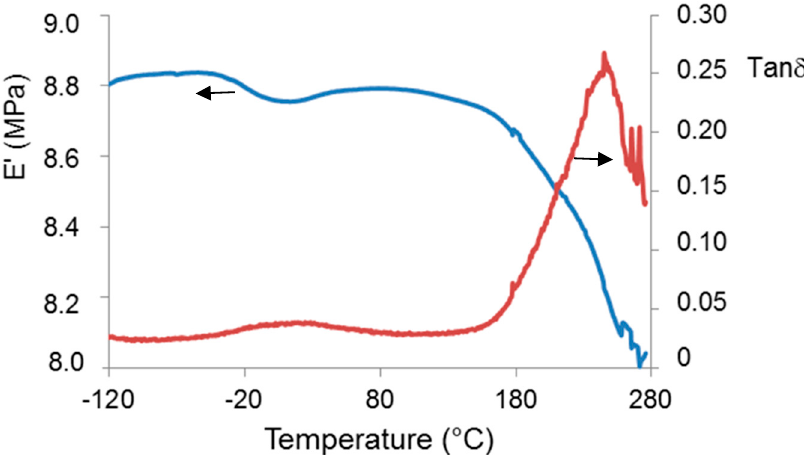
Figure 4. Dynamic–mechanical curves (red curve: loss tangent, tan δ ; blue curve: storage modulus, E’) of γ‐ PGA.